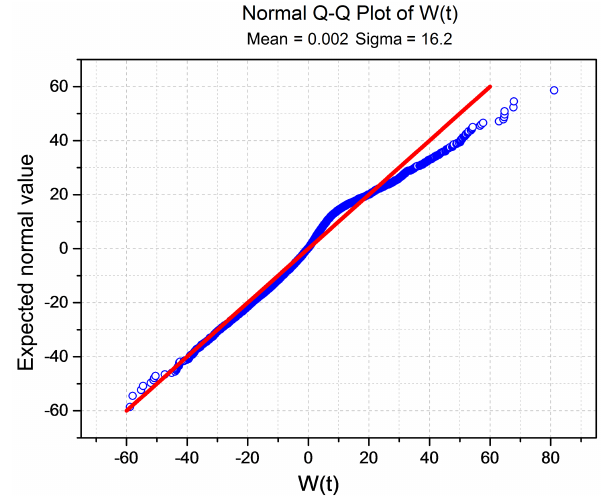
Figure 3. Q – Q plot of the short-term component W(t) for ozone.